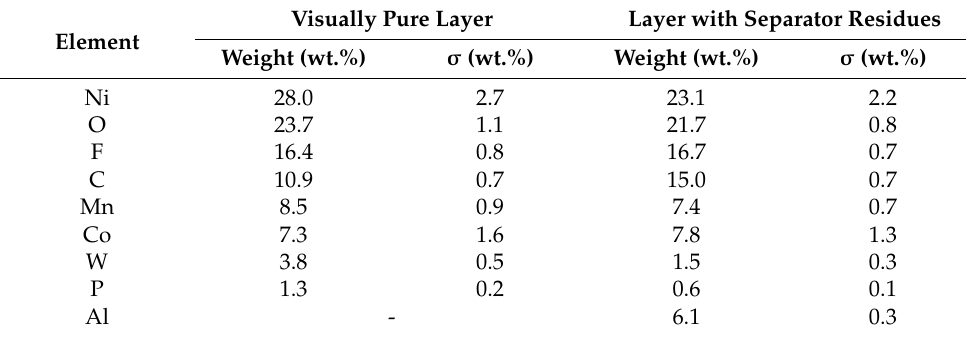
Table 2. Results of the EDS element map for the battery cathode. Visually Pure Layer Layer with Separator Residues Element Weight (wt.%)